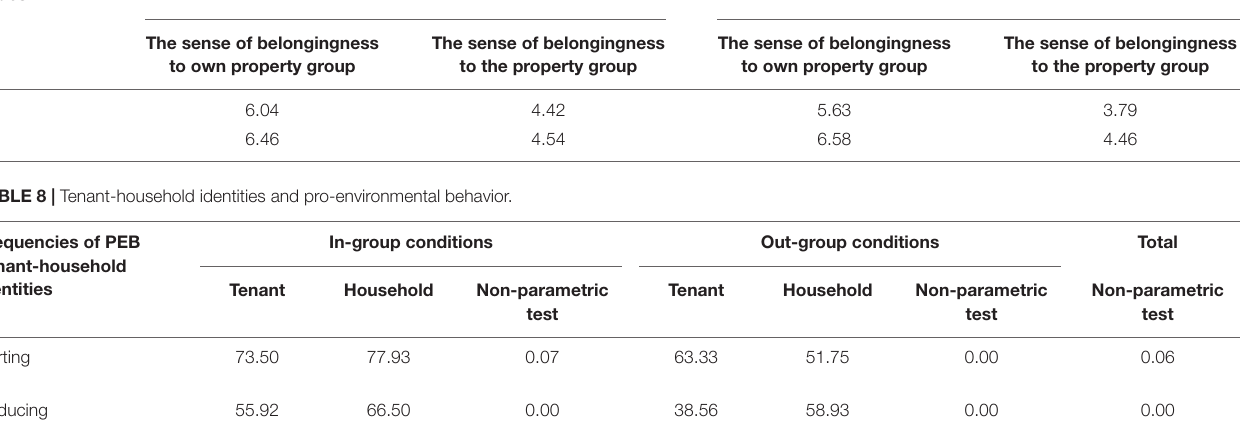
TABLE 7 | The sense of belongingness. Treatment codes